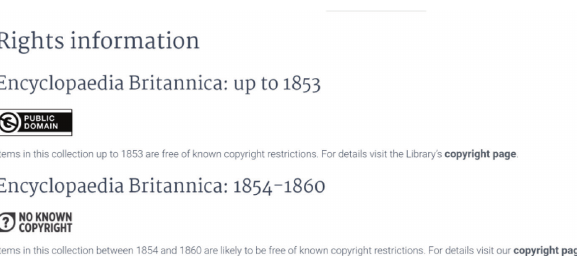
Fig. 2: A dataset spanning two rights